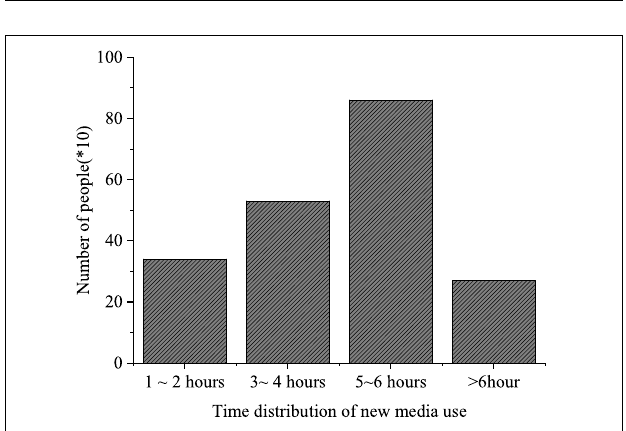
FIGURE 9 | Questionnaire Survey of the new media utilization time.